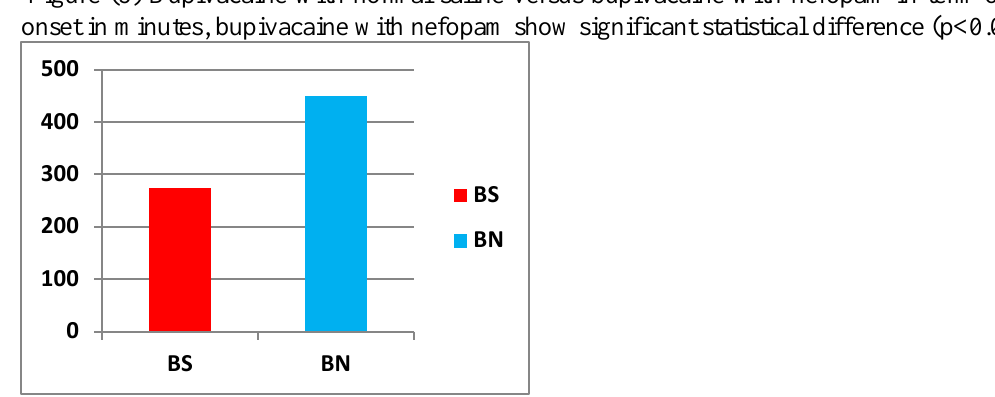
Figure (6) Bupivacaine with normal saline versus bupivacaine with nefopam in term of sensory block duration in minutes, bupivacaine with nefopam show significant statistical difference (p<0.001).